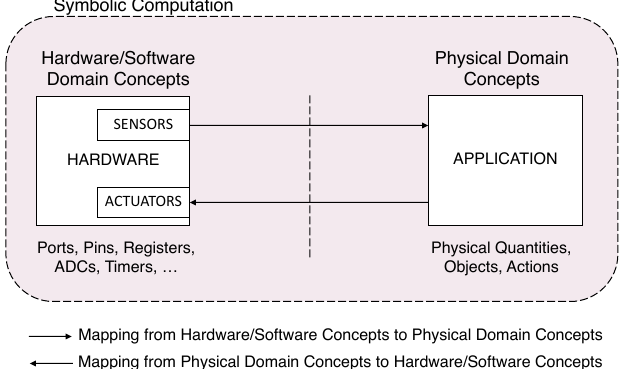
Figure 6. The Physical Domain is bidirectionally mapped to an internal hardware representation through sensing and actuation devices. Executable words of an application are defined in terms of lower level words concerning ports, registers, timers, and other hardware